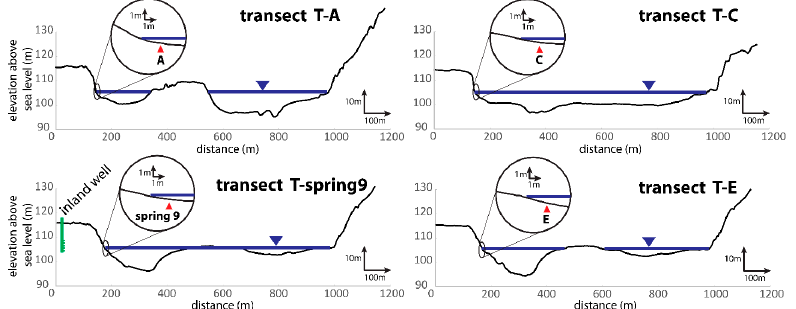
Figure 2. Transect profiles at T-A, T-C, T-spring9, and T-E at 1:10 aspect ratio (vertical : horizontal). The insets of the plots showed the locations of the measurements in zoomed in 1:1 aspect ratio plots.